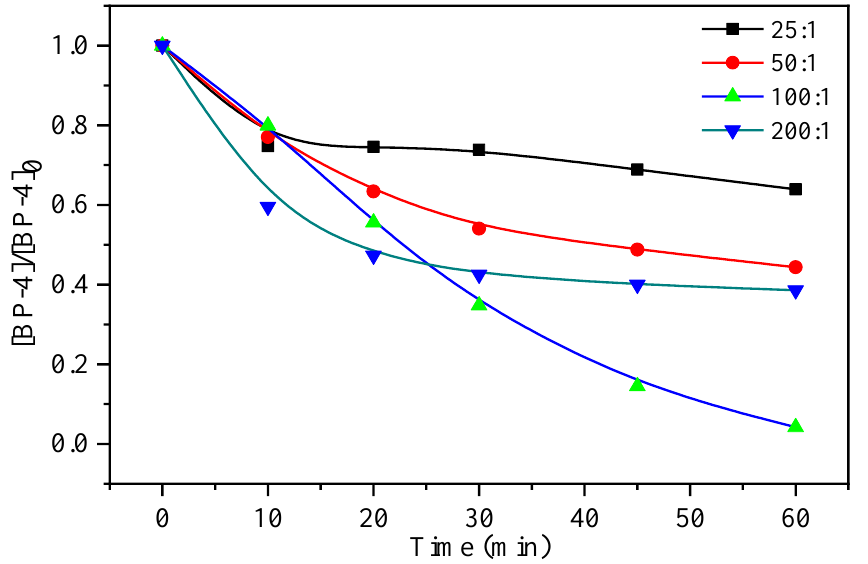
Figure 1. Effect of dose of oxidants ([Fe(VI)) on the removal of BP-4 (experimental conditions: [BP-4] 0 = 5 mg/L; pH = 7.0 ± 0.2; T = 25.0 °C; reaction time = 90 min).